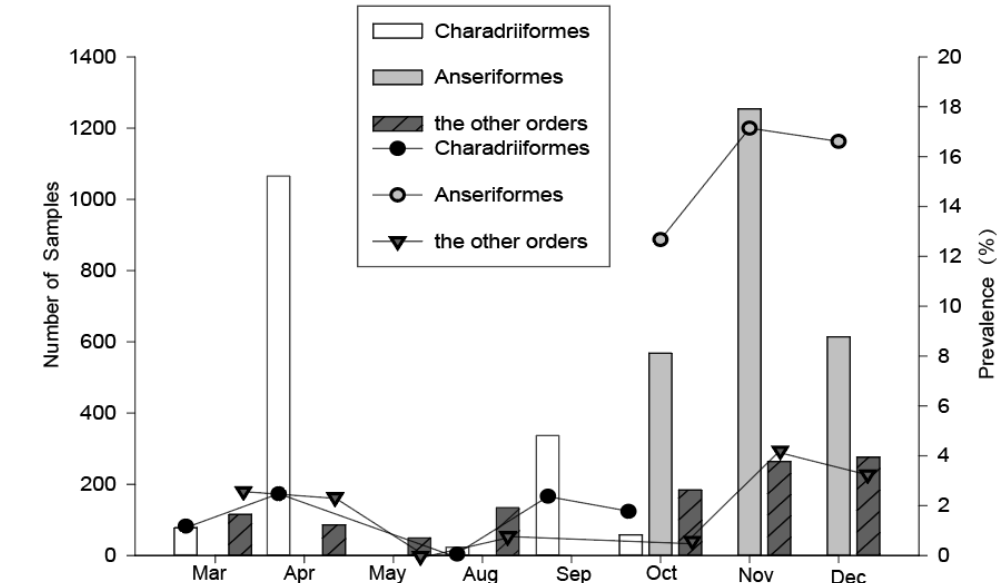
Figure 2. Temporal variation of the overall number sampled and the avian influenza A virus (AIV) prevalence among wild birds during 2016–2018 in Shanghai. Data from 2016–2018 were pooled, the AIV positive rates were detected using quantitative real-time reverse transcription polymerase chain reaction (qRT-PCR).